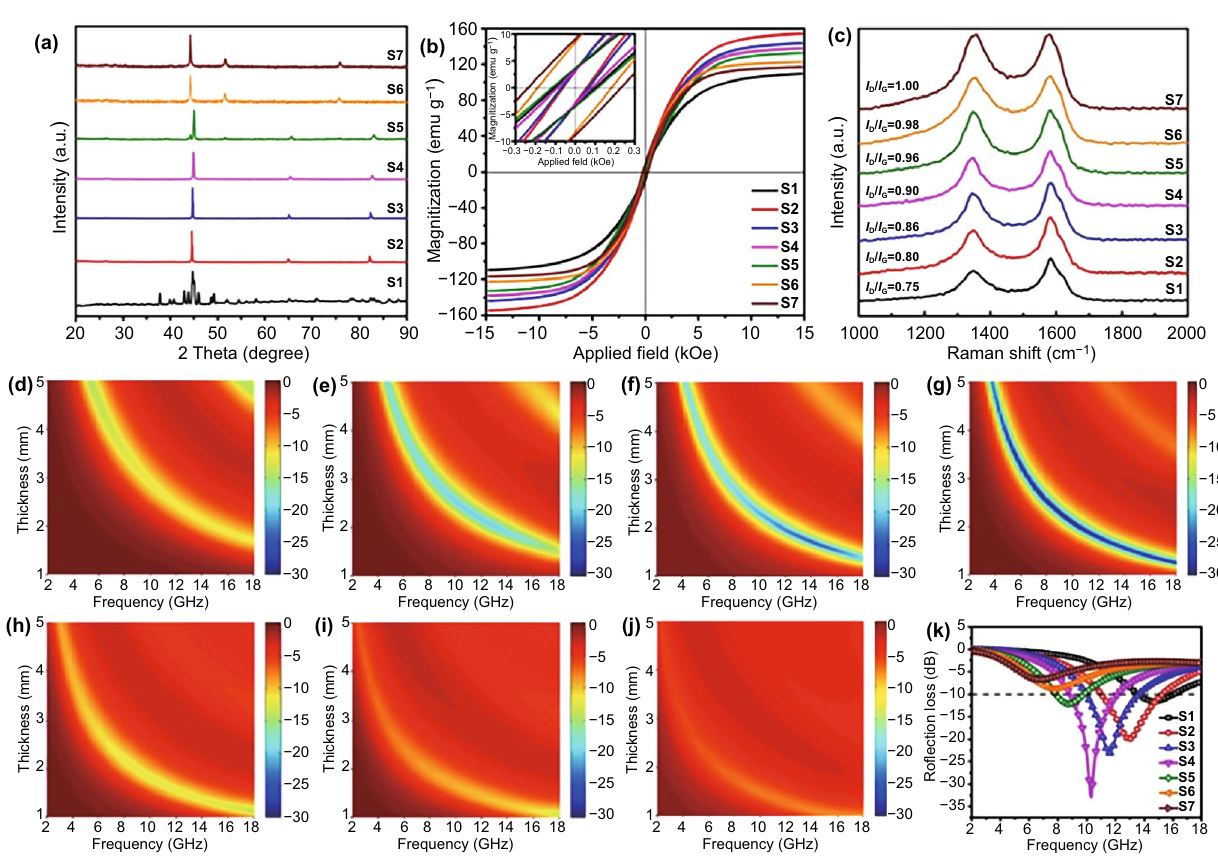
Fig. 2 a XRD patterns, b field-dependent magnetization curves (inset is a magnification of magnetic hysteresis loops), c Raman spectra of S1-S7, and RL maps of d S1, e S2, f S3, g S4, h S5, i S6, j S7, and k their RL curves with the absorber thickness of 2.0 mm. Reproduced with permission from Ref. [63]. Copyright © 2018 Elsevier